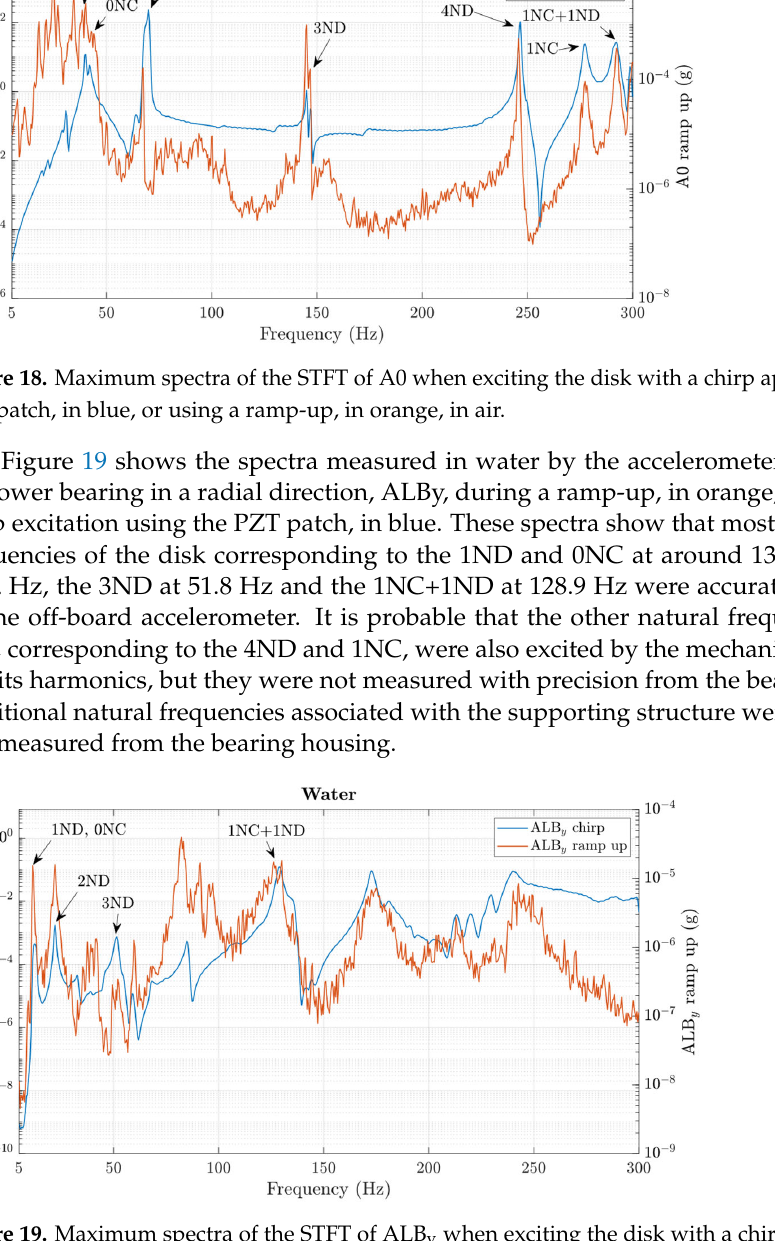
Figure 19. Maximum spectra of the STFT of ALB y when exciting the disk with a chirp applied using the PZT patch, in blue, or using a ramp ‐ up, in orange, in